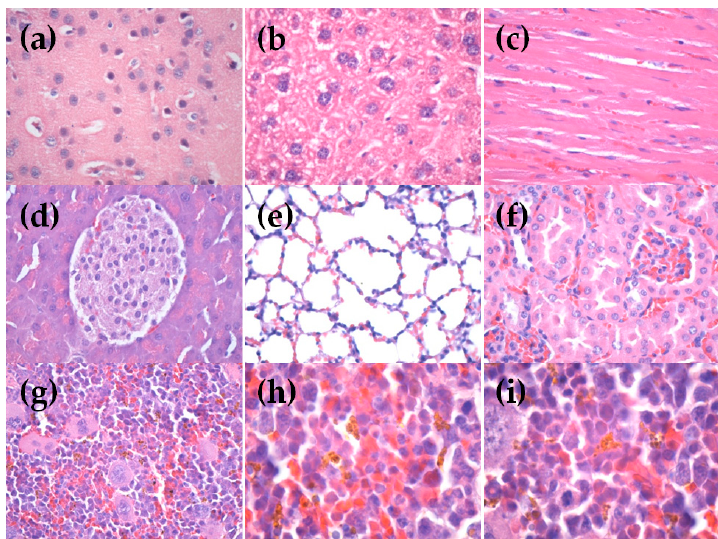
Figure 6. Cross ‐ section of Fe 3 O 4 @PAT nanoparticles treated mouse brain ( a ), liver ( b ), myocardium ( c ), pancreas ( d ), lung ( e ), kidney ( f ), spleen ( g–i ). Collected sample after 7 days. Nanoparticles were observed only in the red pulp. Hematoxylin ‐ Eosin staining (HE): ×400 ( a – g ); ×1000 ( h , i ). The nanoparticles functionalized with PAT were absent in the brain, as well as in the liver, myocardium, pancreas, lung and kidney after 14 of administration (Figure 7). In exchange, in the spleen, the functionalized nanoparticles were found only in the red pulp in a concentration higher than in samples taken after 7 days and were absent in the white pulp. However, in the white pulp we observed hypertrophy due to the fact that nanoparticles stimulated the formation of macrophages with multilobular nucleus. In the red pulp, the nanoparticles were found in the macrophages from both Billroth cords and the capillaries and sinusoids. The nanoparticles have been evidenced as brown ‐ blackish, granular, spherical agglomerates of varying size, with a diameter of up to 3 μ m. The density of the endocyted nanoparticles varied from one cell to another (Figure 7).